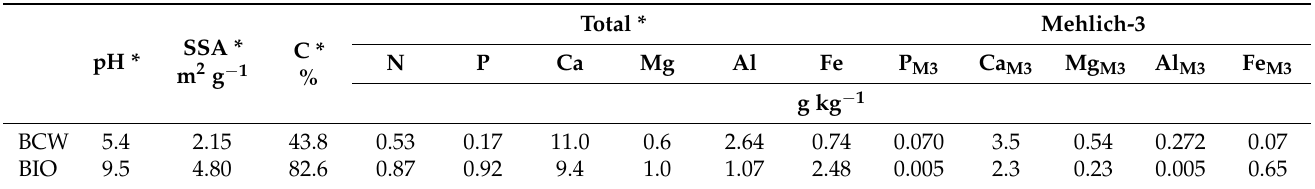
Table 1. Properties of tested brown coal waste (BCW) and conifer woodchip biochar